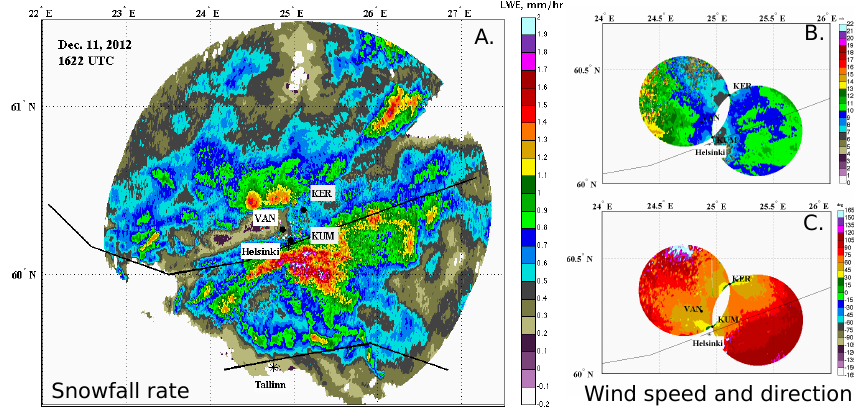
Fig. 3. Helsinki weather radar network observations: (a) precipitation (snowfall) rate as measured by the three radars, (b) – (c) dual-Doppler wind speed and direction estimated from Kumpula and Kerava radar